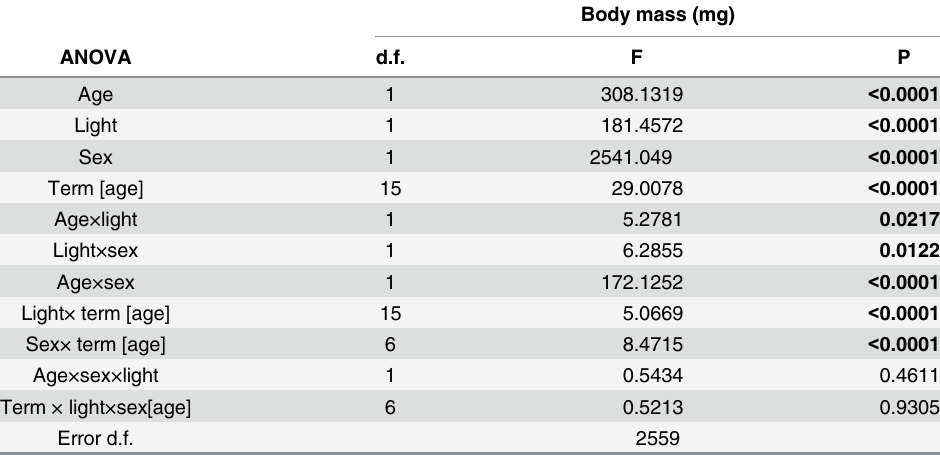
Table 3. Summary of ANOVA on the effects of time of occurrence (age: current-year vs 1-year-old), light conditions (high light vs shade), sex (female vs male), term (length of the sampling period, see Materials and Methods) and their interactions on the body mass of adult Altica brevicollis coryletorum beetles. The factor “ term ” was nested in the factor “ age ” (term[age]). P values < 0.05 are in